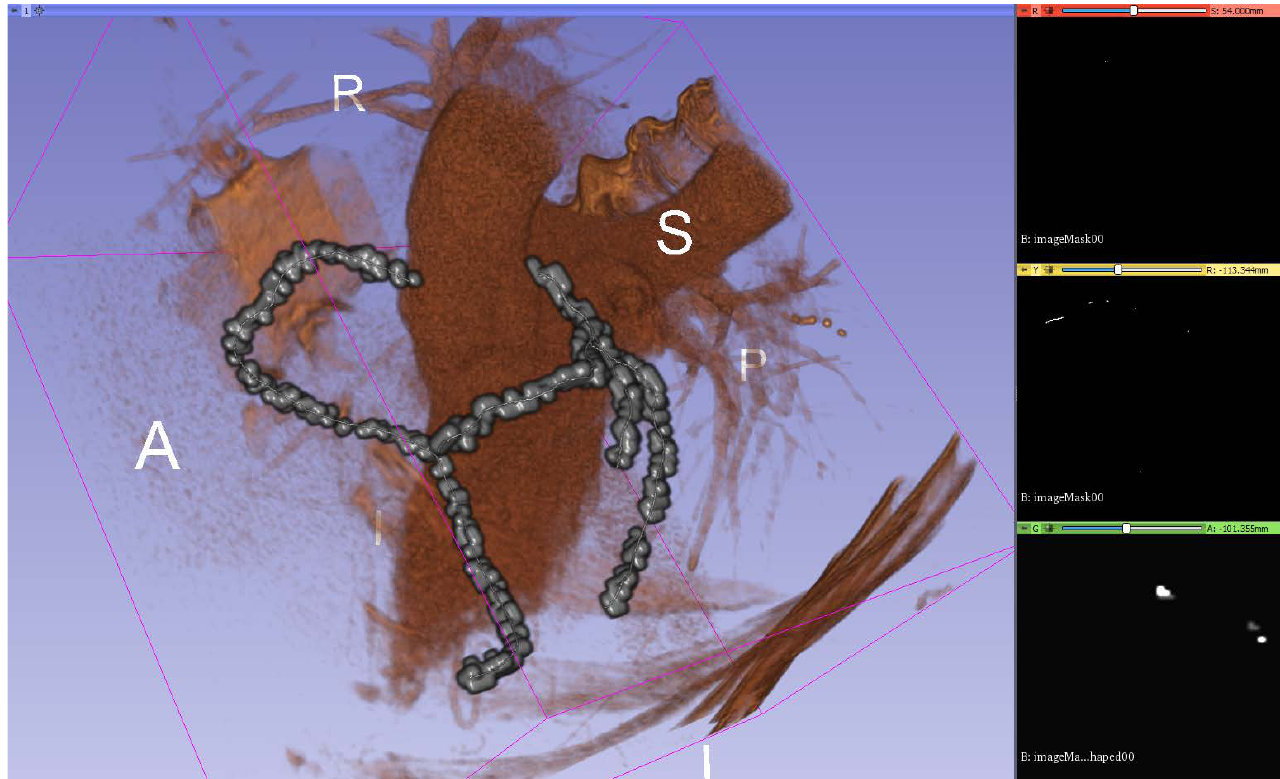
Figure 2. Downscaled and upscaled centerline ground truth (80 × 80 × 64) plotted in 3D to highlight the difficulty of using it for